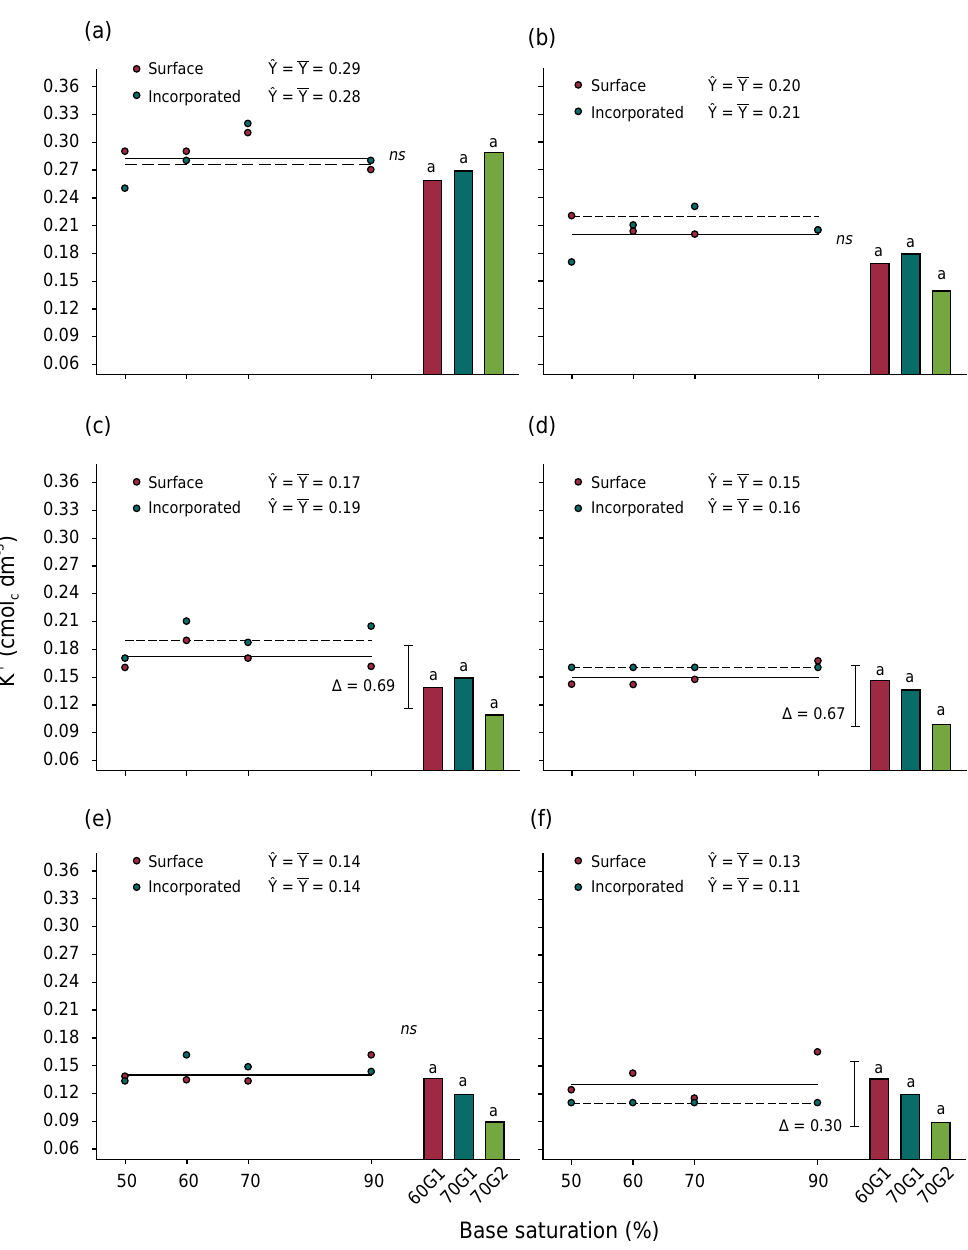
Figure 6. Potassium (K + ) levels in in the 0.00-0.05 (a), 0.05-0.10 (b), 0.10-0.20 (c), 0.20-0.30 (d), 0.30-0.40 (e), and 0.40-0.60 m (f) layers 48 months after treatment. Soils were limed to different base saturation (BS) levels (50, 60, 70, and 90 %) by surface application (SL) or lime incorporation ( IL ) or treated by surface application of lime (60 and 70 % BS) and a standard (G 1 ) or double (G 2 ) dose of phosphogypsum as 60G1, 70G1, and 70G2. Different letters above columns indicate significant differences between phosphogypsum treatments (Tukey’s test, p<0.05). Vertical bars represent least significant differences between treatments (Dunnett’s test,